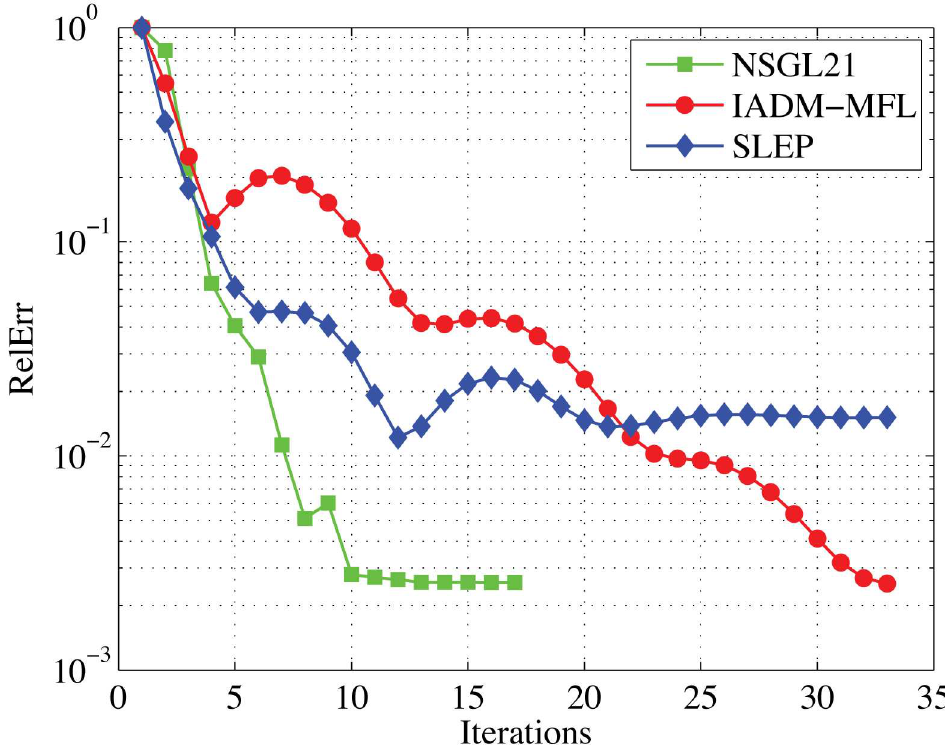
Fig 1. Comparison results of NSGL21, IADM MFL, and SLEP. The x-axes represents the number of iterations and the y-axes represents the relative error.